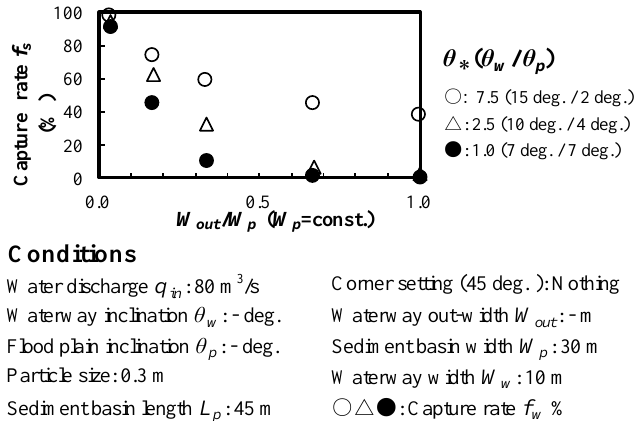
Figure 26. Effects of changes in the downstream opening width and gradient of the sediment retarding basin on sediment capture.